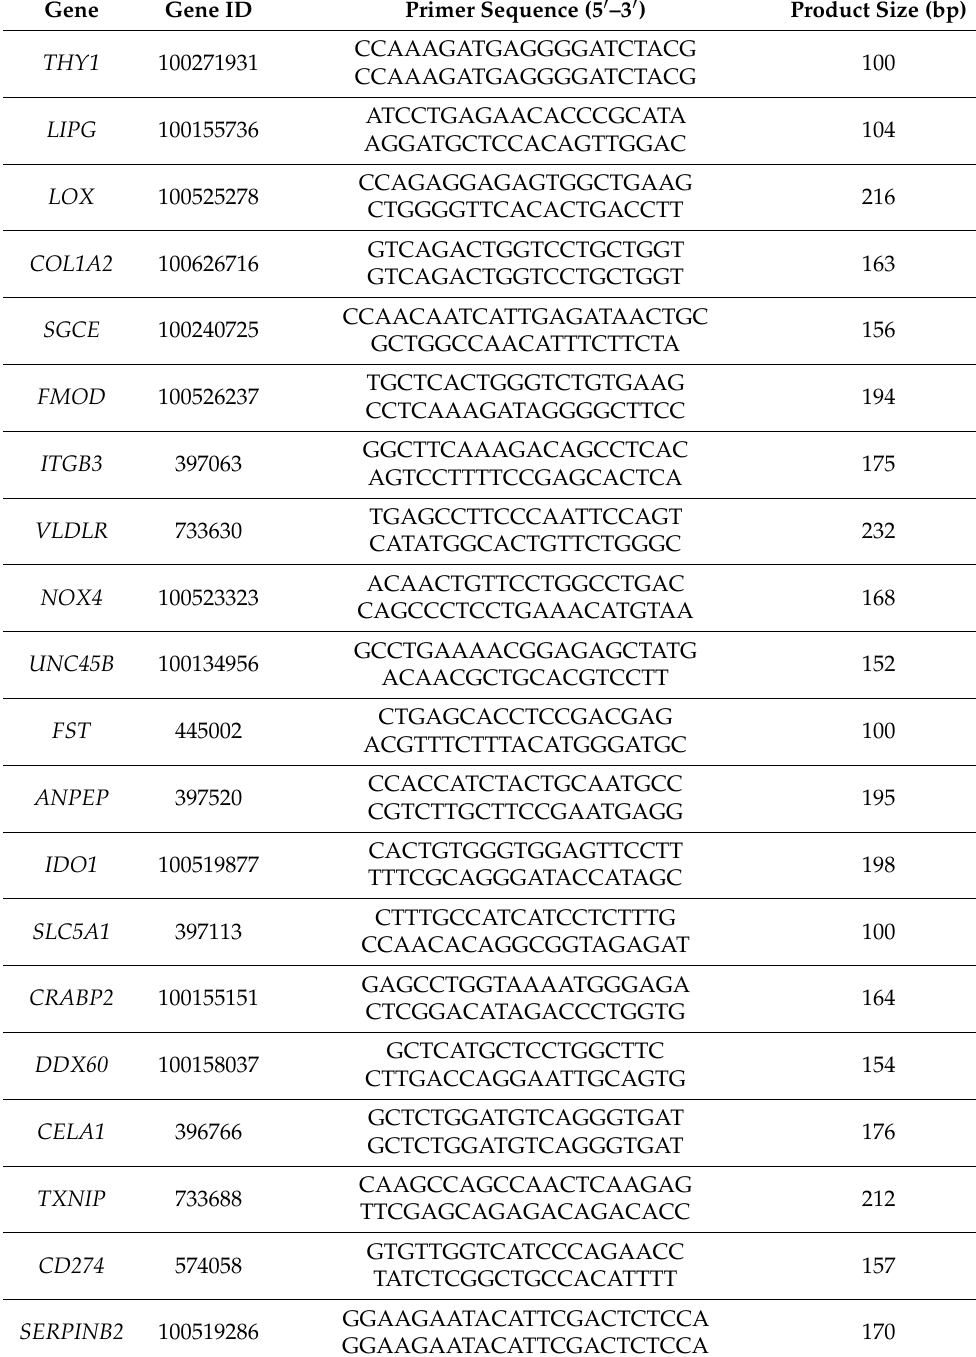
Table 2. Oligonucleotide sequences of primers used for RT-qPCR